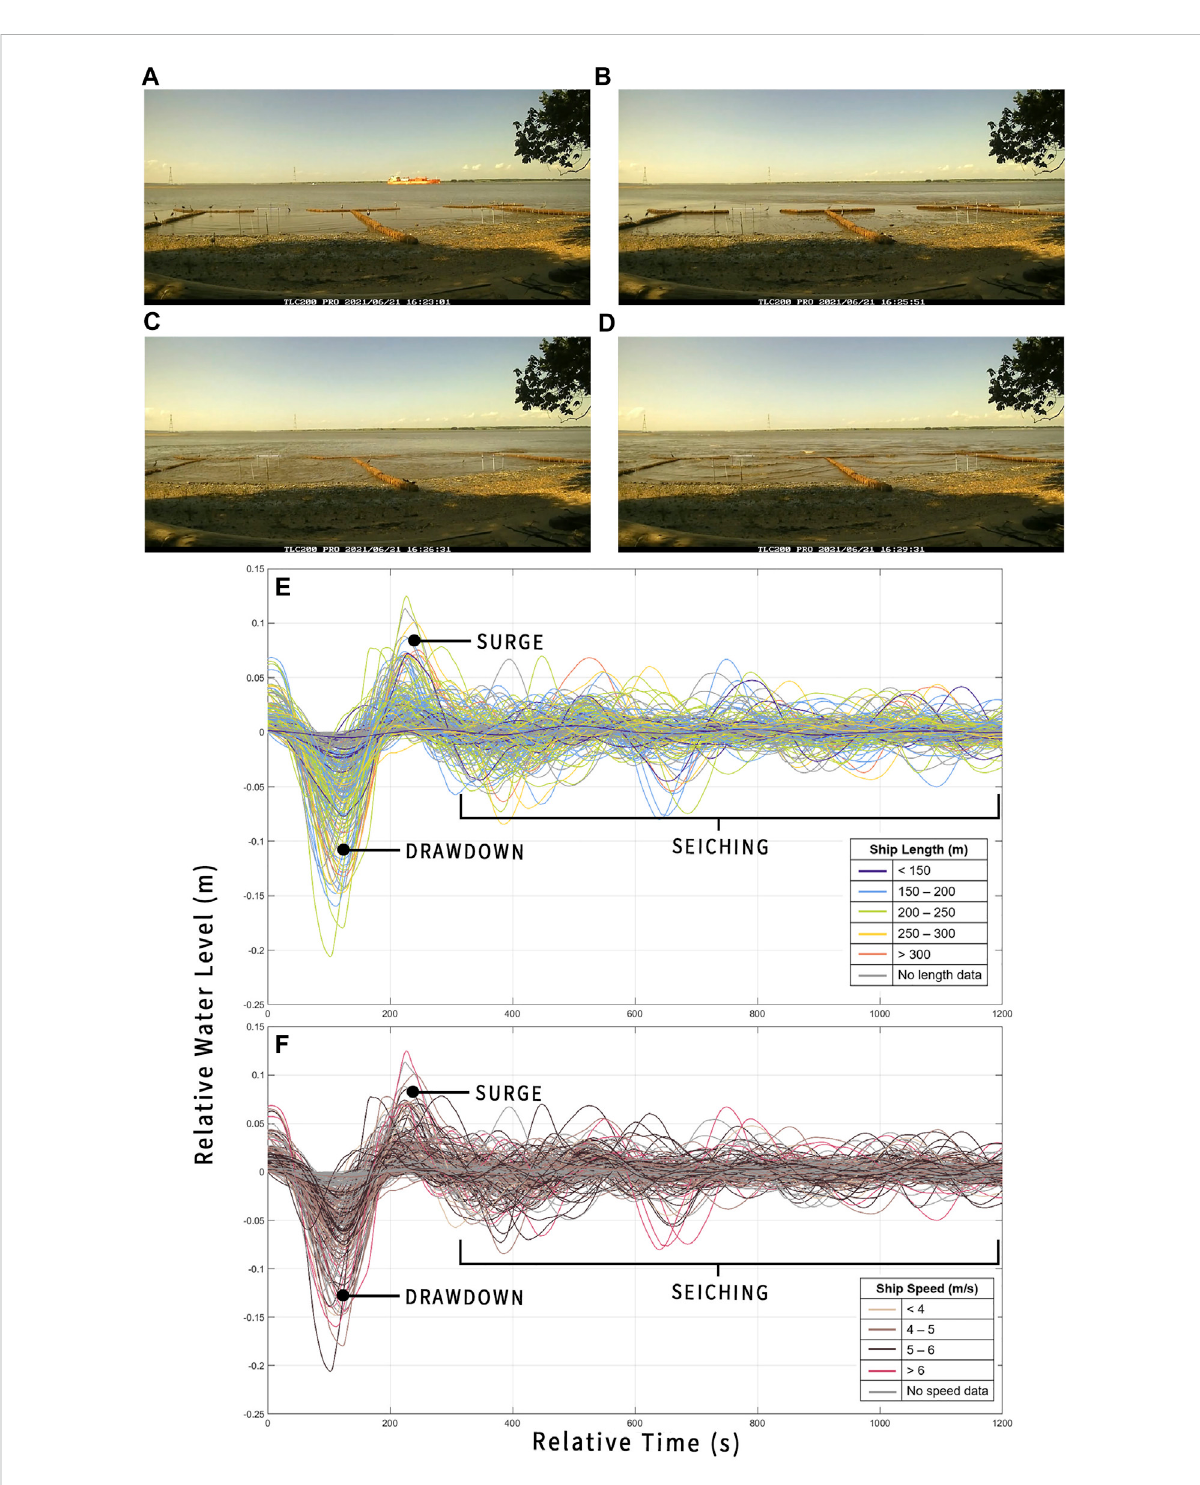
FIGURE 7 Snapshotsofsignatureshipwakeeventstructure: (A) elevatedwaterlevelwithshippath, (B) drawdown, (C) surge,and (D) high-frequencywave train. The low-frequency water level follows the graph of each event in (E) and (F) with notable features called out. Events are organized by ship length in (E) and average ship speed in (F)